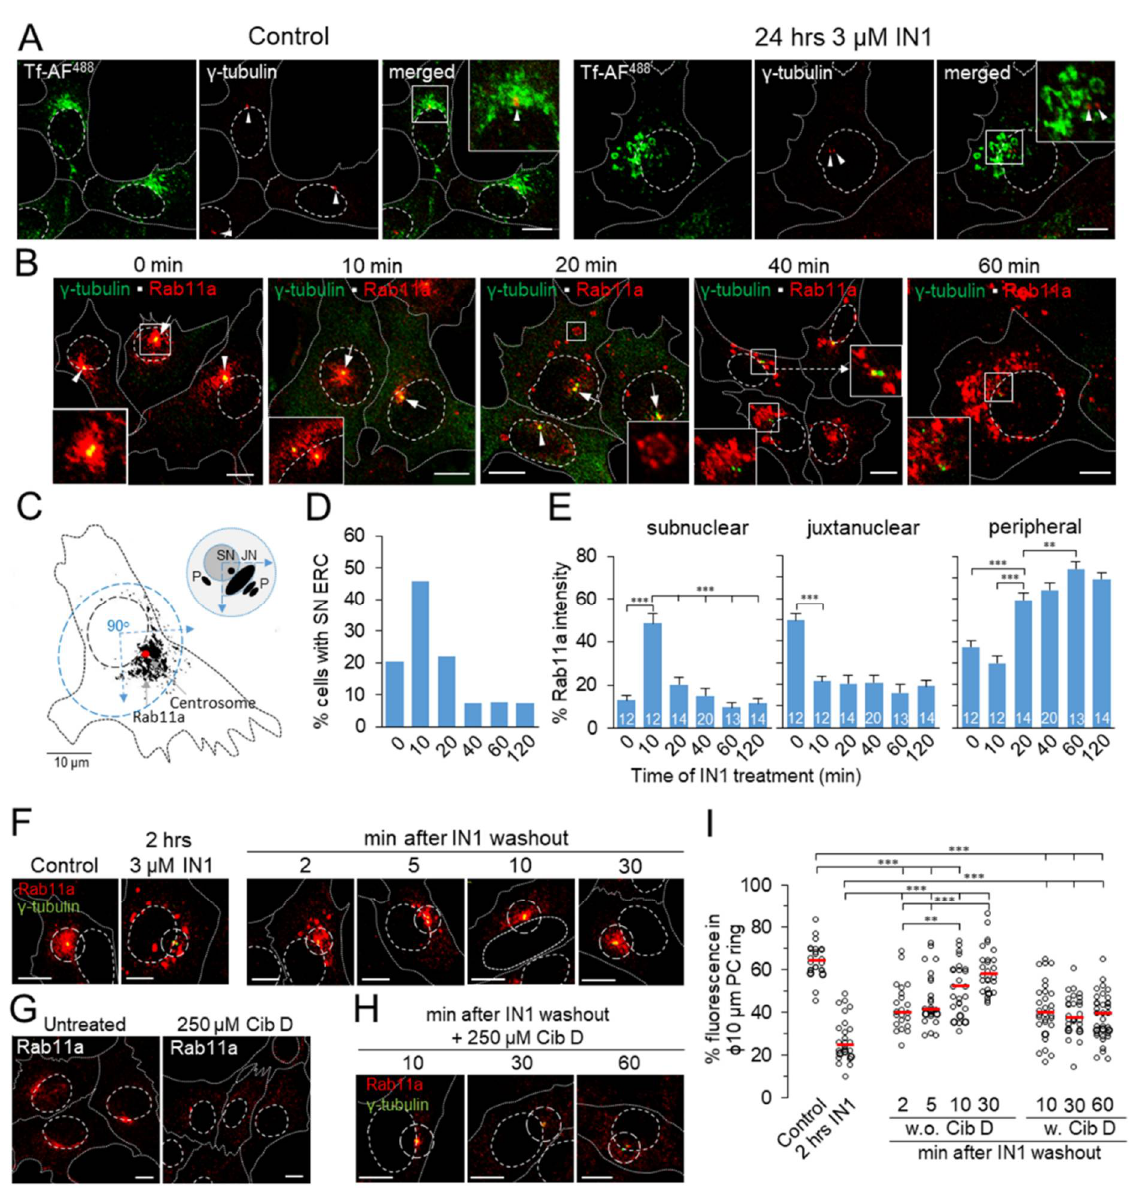
Figure 4. Reorganization of the pericentriolar recycling system in PI3P-depleted cells. ( A ) Representative images ( n = 8–12) of 45 min internalized Tf-AF 488 and γ -tubulin in control and 24 h IN1-treated Balb 3T3 cells. ( B ) Representative overlaid images of γ -tubulin and Rab11a in cells treated with IN1 for 0–60 min. Insets show zoomed area box. Arrowheads indicate juxtanuclear accumulation, and arrows indicate subnuclear Rab11a staining. ( C ) Subcellular Rab11a distribution zones relative to centrosomes on control cell images and schematic representation of subnuclear (SN), juxtanuclear (JN), and peripheral ( p ) areas used for ImageJ quantification of Rab11a distribution signal. ( D ) Percentage of cells with subnuclear ERC distribution after 0–120 min treatment with 3 μM IN1. ( E ) Quantification of Rab11a distribution across three zones in cells after 0–120 min treatment with 3 μM IN1. The intensity of Rab11a in the SN, JN, and p zones was quantified on the images using ImageJ relative to the total intensity in the whole cells. Data are mean ± SEM (number of cells indicated in bars); *** p ˂ 0.001, ** p ˂ 0.01 (one-way ANOVA). ( F ) Representative overlaid images of Rab11a distribution (red fluorescence) relative to centrosomes stained with γ-tubulin (green fluorescence) after 120 min of IN1-treatment, followed by IN1 washout and incubation in IN1-free medium for 2–30 min. Representative images of all samples are shown in Supplemenatyr Materials